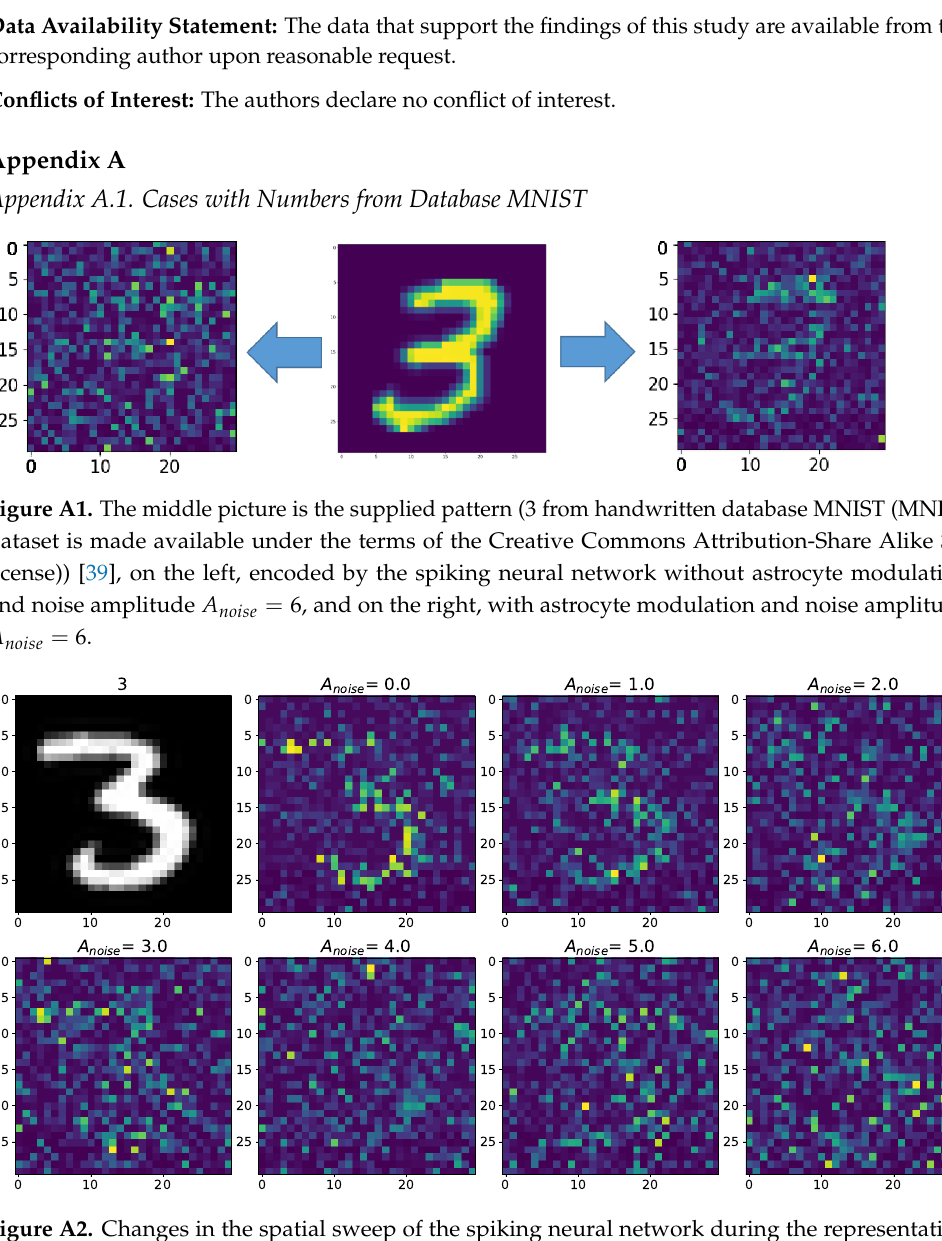
Figure A2. Changes in the spatial sweep of the spiking neural network during the representation of the supplied image from the Figure A1 when the amplitude, A noise , of the noise current, I noise , changes from 0 to 6 without modulation of neuronal activity by